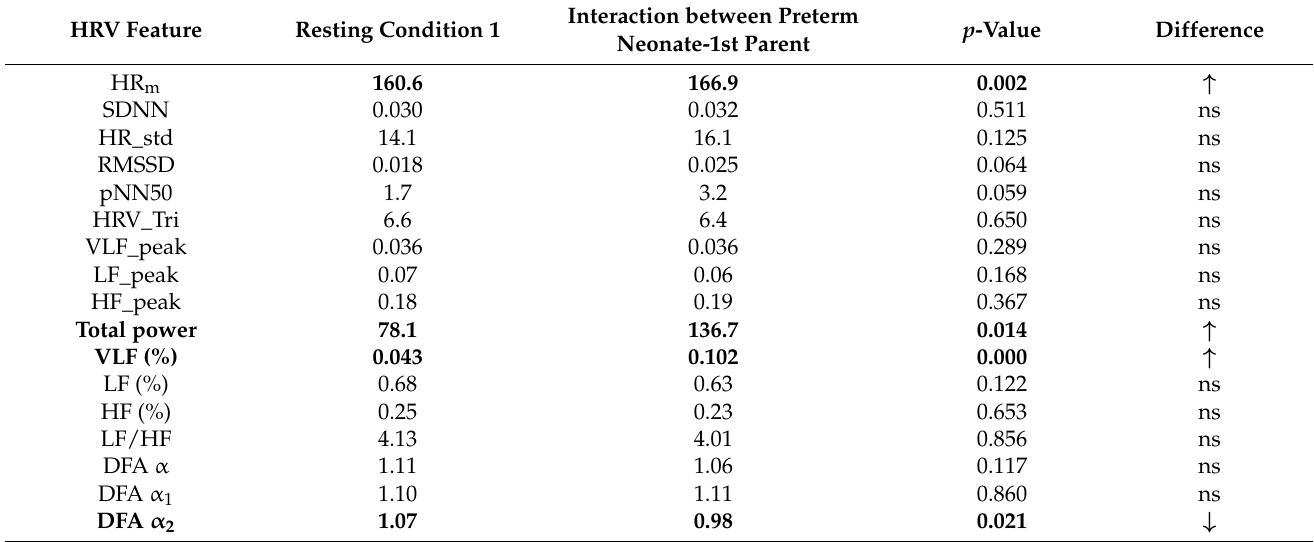
Table 6. Comparison of preterm infants’ HRV parameters between resting condition 1 and interaction with the 1st parent interaction and interaction with the 1st parent.